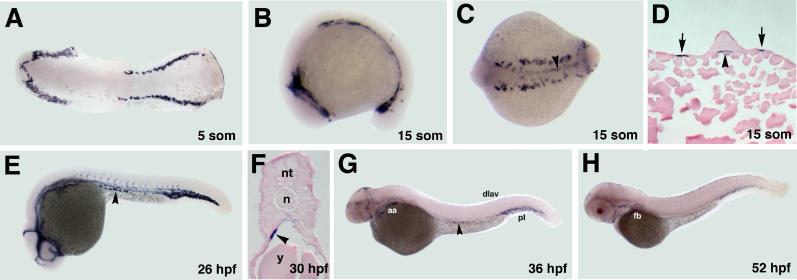
Expression Pattern of etsrp as Analyzed by In Situ HybridizationAnterior is to the left except as noted. (A) five-somite stage. etsrp is expressed within lateral mesoderm in two distinct expression domains, in the anterior and posterior parts of an embryo. (B) 15-somite stage, lateral view. (C) dorsal view. (D) transverse section. etsrp is expressed in two bilateral stripes of presumptive angioblasts within the lateral mesoderm in the anterior and the trunk and posterior parts of an embryo (arrows, D). In addition, a stripe of etsrp-expressing cells is apparent at the midline and extends through the middle and posterior parts of an embryo (arrowhead, C and D). (E) 26 hpf stage. etsrp is expressed in vascular endothelial cells of the axial, head, and intersomitic vessels. Note a group of etsrp-expressing cells bilaterally located in the intermediate mesoderm (arrowhead). (F) Transverse section through the trunk region of a 30 hpf embryo. Arrowhead shows one of the etsrp-expressing cells located within the lateral/intermediate mesoderm. Expression of etsrp in the axial vessels is weak at this stage and not apparent in this section. nt, neural tube; n, notochord; y, yolk. (G) 36 hpf stage. etsrp is expressed in a subset of head vessels, the aortic arches (aa), the cardinal vein plexus (pl) region, posterior intersomitic vessels, and the dorsal longitudinal anastomotic vessel (dlav). Note a group of etsrp-expressing cells located in the endodermal region (arrowhead). (H) 52 hpf stage. etsrp expression is observed in a subset of head vessels, common cardinal vein, pectoral fin bud blood vessels (fb), cardinal vein plexus region, and weakly in posterior intersegmental vessels and the dorsal vessel.